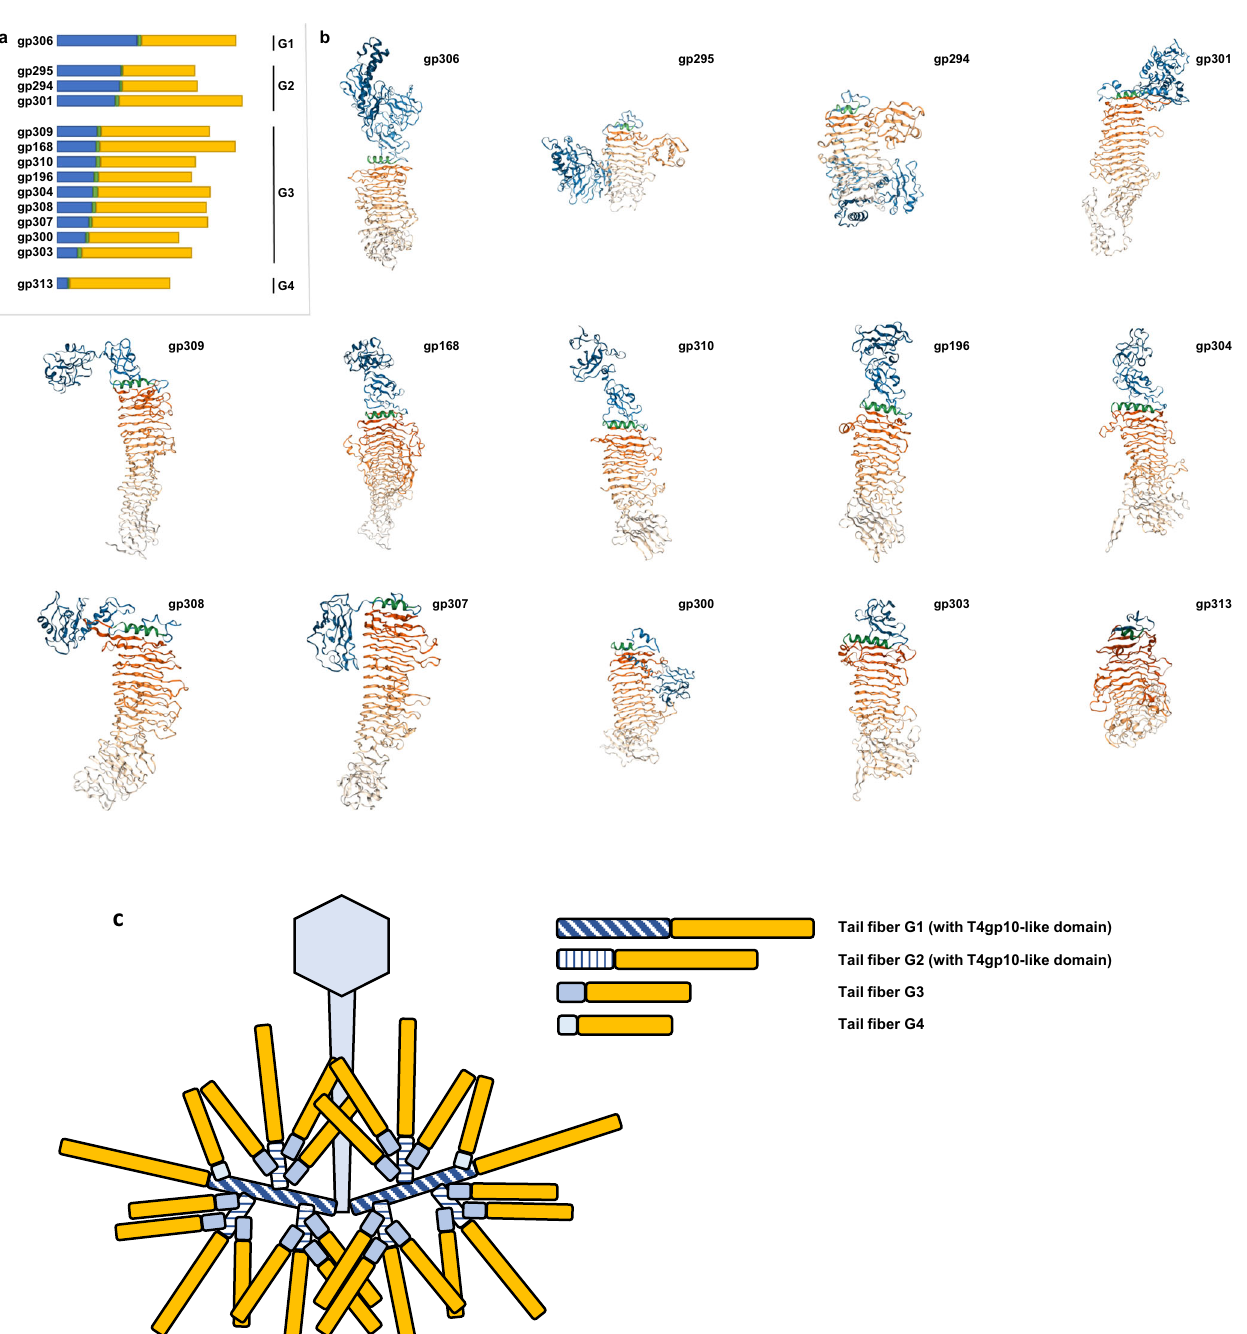
Fig. 7 | In silico structural analyses of tail fi bers with predicted depolymerase activity.a Schematicdelineationofthedifferentmodulesin14predictedtail fi bers resultsinfourgroups(G1,G2,G3,andG4)accordingtothelengthoftheirstructural modules. Note that the relative orientations of the individual domains in the pre- dicted structure can be different than depicted. b Fourteen predicted tail- fi ber